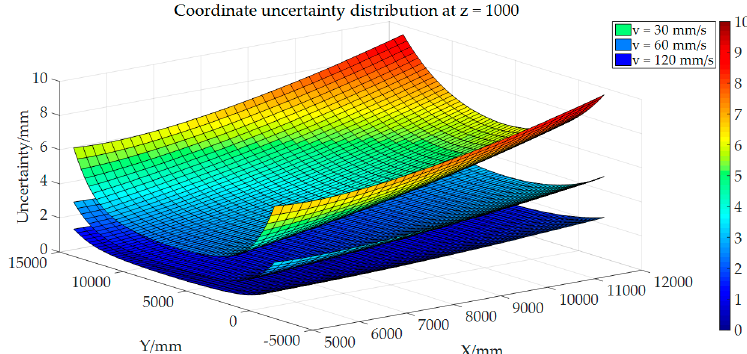
Figure 8. Coordinate uncertainty distribution of points at z = 0.